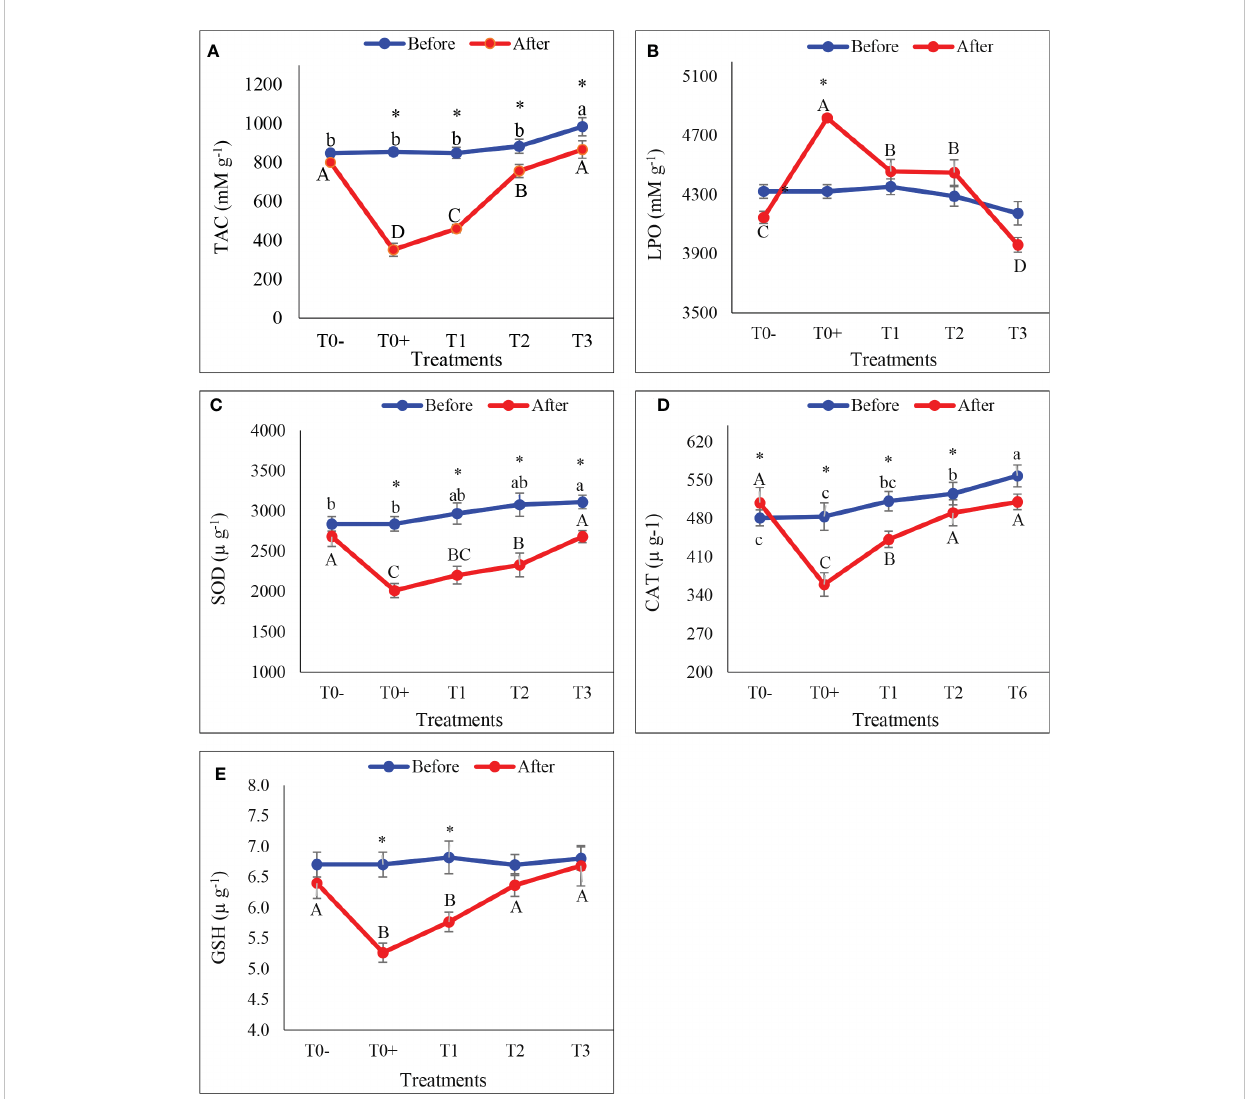
FIGURE 7 the gills total antioxidant capacity ( A : TAC), lipid peroxidase ( B : LPO), superoxide dismutase ( C : SOD), catalase ( D : CAT, and glutathione ( E : GSH) of red tilapia fed different ratios of corn oil (CO): Aquafat-O ® (AQ-O) and exposed to cold stress. T 0- (the negative treatment); T 0+ (the positive treatment); T 1 (2 CO: 1 AQ-O); T 2 (1 CO: 2 AQ-O); T 3 (3 CO: 0 AQ-O). Vertical bars indicate the standard errors; means with an asterisk indicate a signi fi cant difference between before and after the exposure to cold stress ( p ≤ 0.05). Small and capital letters indicate signi fi cant differences among treatments before and after the exposure to cold stress,